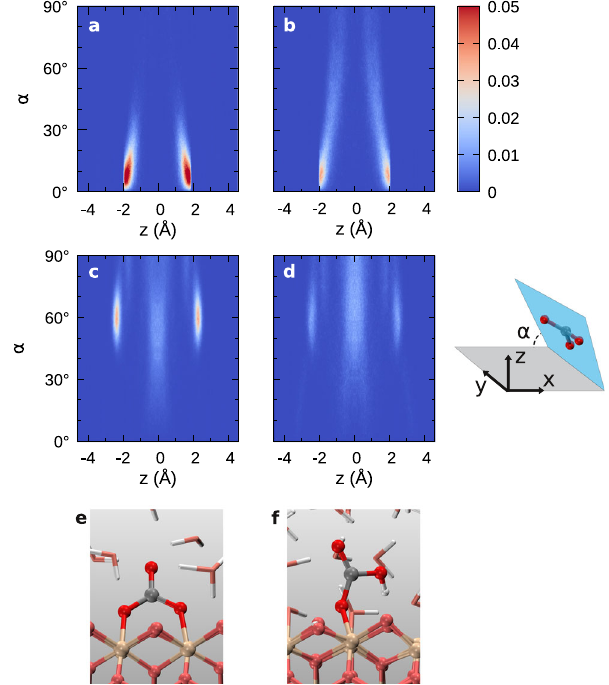
Fig. 4 | Orientation distributionofsp 2 carbonspeciesin CO 2 (aq)solutions. The dihedralangle α isbetweenthecon fi nementinterfaceandtheplanede fi nedbythe three oxygen atoms in sp 2 carbon species. a , b The solutions under graphene con fi nement at 1000 and 1400K, respectively. c , d The solutions under stishovite con fi nement at 1000 and 1400 K, respectively. The pressure in all solutions are ~10GPa.TheinitialmolefractionofCO 2 (aq)is0.185.Thecenterofcon fi ned fl uidsis set at z =0, and the angle distributions have been symmetrized. e , f The CO 2 (cid:1) 3 and HCO (cid:1) 3 ions adsorbed on the stishovite (100) surface,